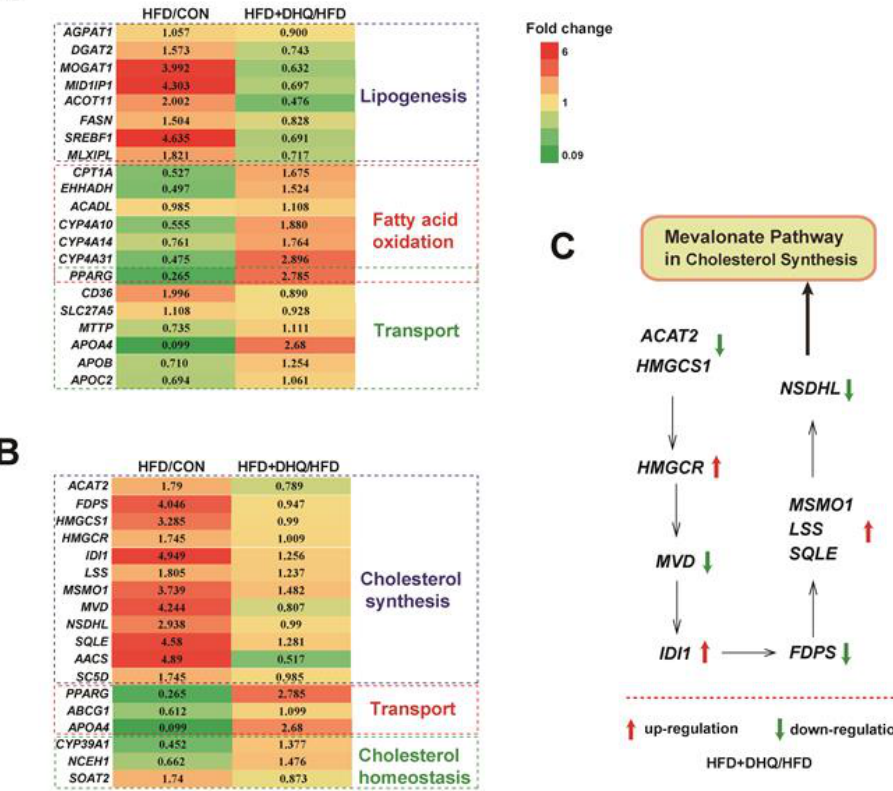
Figure 6. Effects of DHQ on fold change of lipid metabolic-related gene expression in liver in mice. ( A ) TG metabolism-related genes; ( B ) TC metabolism-related genes; ( C ) Mevalonate pathway in cholesterol synthesis. The red arrow represents up-regulation, and the green arrow represents down-regulation.